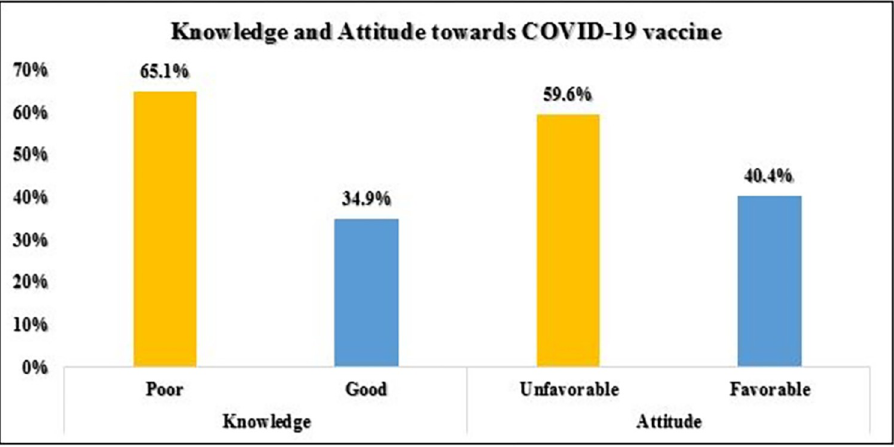
Fig 1. Respondent’s knowledge and attitude towards COVID-19